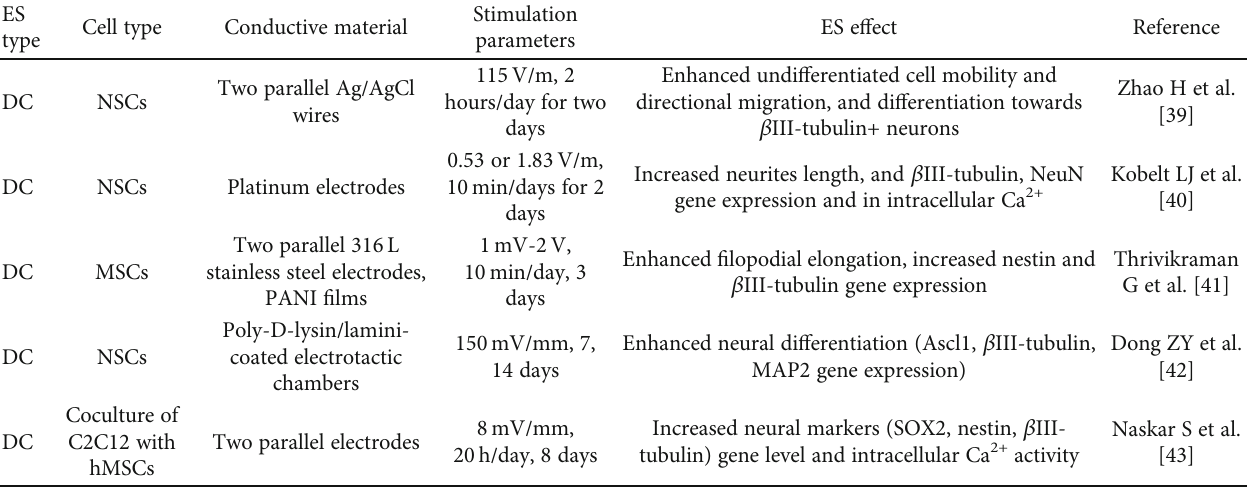
Table 2: Direct current stimulation used in stem cell neural di ff erentiation.